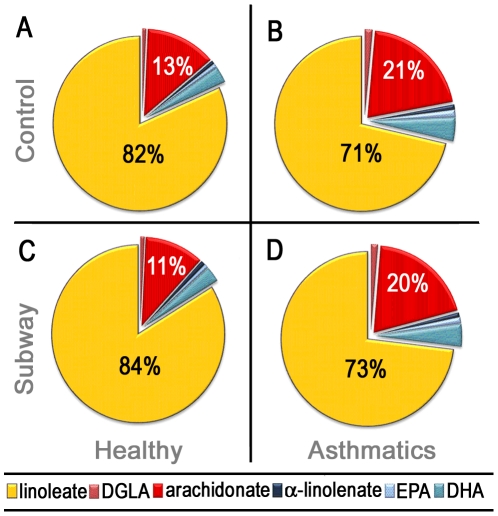
BAL-fluid oxylipin composition among patient groups.Following exposure to control air, healthy individuals (A) and asthmatics (B) evidenced significant differences in oxylipin levels on a fatty acid class-specific basis for linoleates (LA; p = 0.004), arachidonates (AA; p = 0.008), docosahexaenoates (DHA; p = 0.045), dihomo-γ-linolenates (DGLA; p = 0.007), α-linolenates (α-LA; p = 0.035) and eicosapentaenoates (EPA; p = 0.045). Following exposure to subway air, only LA (p = 0.022) and AA (p = 0.013) were significantly different between healthy individuals (C) and asthmatics (D). No significant changes were observed in healthy individuals or asthmatics following exposure to subway air, relative to exposure to control air; (A) vs (C) and (B) vs (D), respectively. The unlabeled fatty acids (DGLA, α-LA, EPA and DHA) are all present at <5% and are presumably more representative of a lack of coverage in the analytical method rather than potential biological differences in relative abundance.